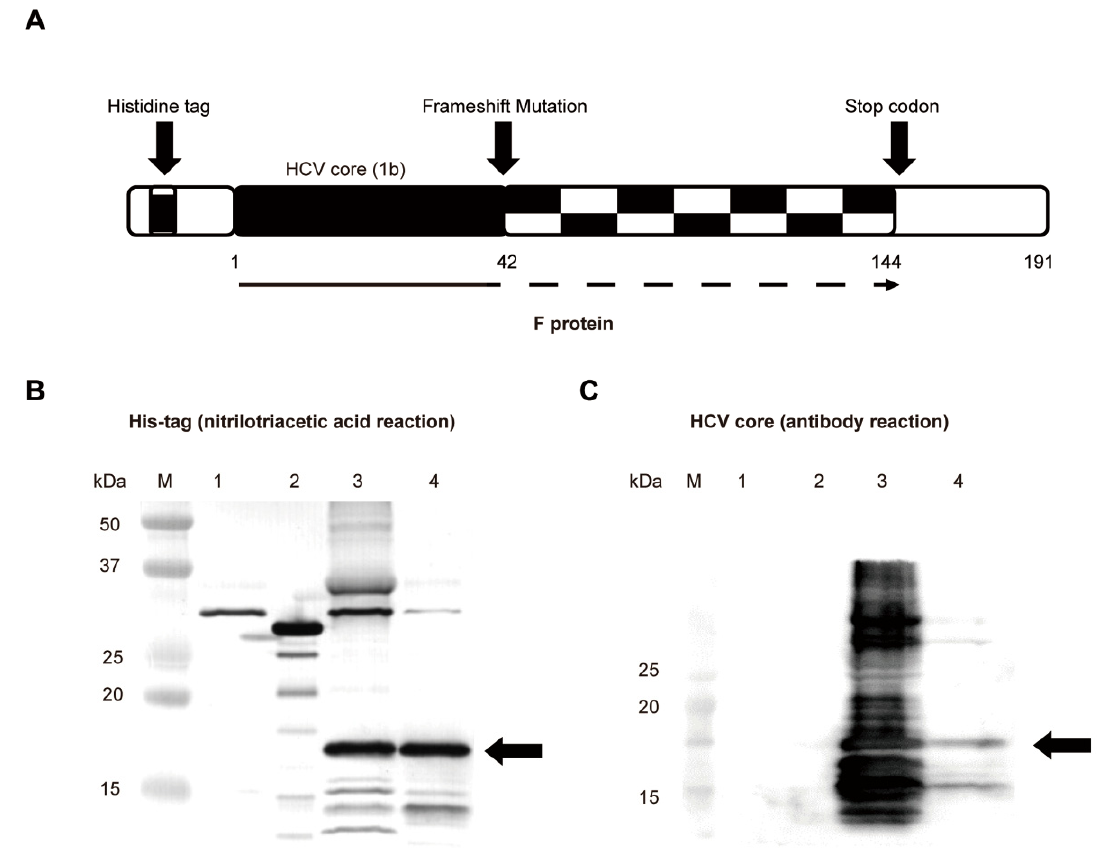
Figure 5. Confirmation of the in vitro synthesized F protein by a Western blot analysis. ( A ) The structure of the HCV F protein expressed in Escherichia coli . It consisted of the wild-type HCV core sequence and the HCV F protein that includes a frameshift mutation at 42 and the introduction of a histidine tag. This results in the induction of a stop codon at 144, and the overall polyprotein was partially shortened. ( B ) Western blotting images of the purified HCV F protein detected by the His tag. The image shows His-tagged bands by a nickel-nitrilotriacetic acid reaction. ( C ) Western blotting images of purified proteins detected by the HCV core antibody with the epitope located within codons 1–42. The black arrow shows the synthesized HCV-F protein band. M, molecular marker; 1, negative control: empty vector; 2, positive control for the His tag: PA tag-EGFP-6XHis tag; 3, non-purified F protein; 4, His-tagged purified F protein.